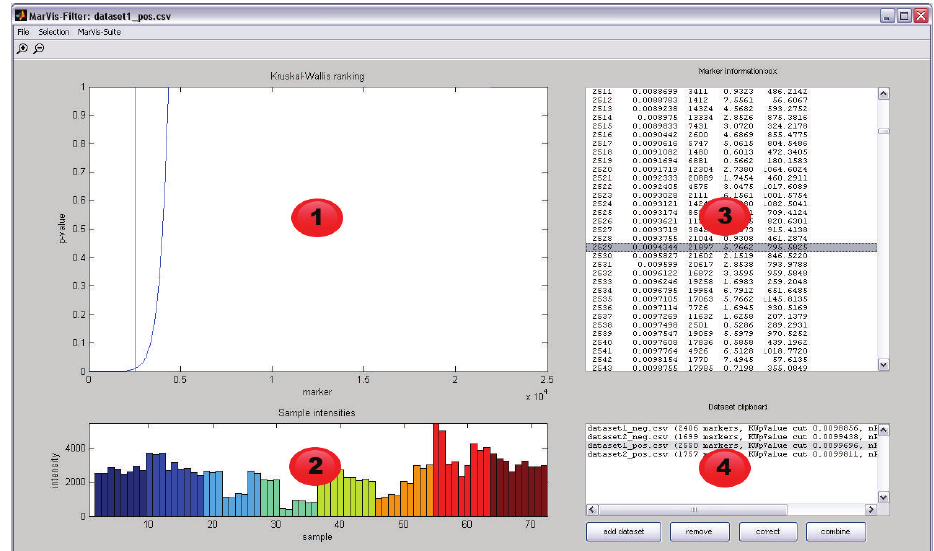
Figure 1: The main window of MarVis-Filter after data import and ranking. The “Ranking plot” (1) displays the adjusted P values ( y -axis) of all candidate intensity profiles. The “Profile plot” (2) shows the raw intensity profile of the currently selected marker candidate. The “Marker listbox” (3) displays information about the current marker candidate. The “Data set clipboard listbox” (4) shows data sets which are currently held in the MarVis clipboard.